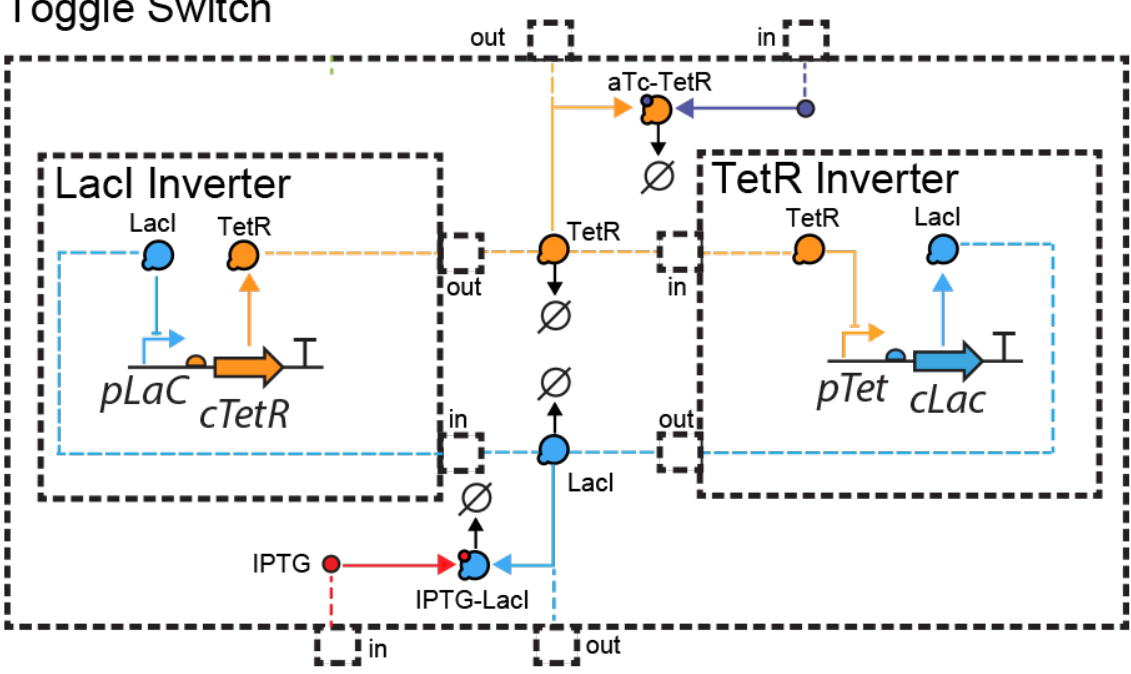
Figure 28: Design of a LacI/TetR toggle switch. This design is composed of two inverter sub-designs, each containing a single gene. These genes mutually repress each other’s expression via their encoded protein transcription factors, LacI and TetR. Furthermore, both LacI and TetR are bound by specific small molecules that sequester them and prevent them from acting as repressors. In this design, arrows represent different molecular interactions, including the repression of pLac via LacI, the non-covalent binding of IPTG to LacI, the transcription of TetR mRNA, and the translation of TetR. Dashed lines serve to map between transcription factors in the inverter sub-designs and those in the overall toggle switch